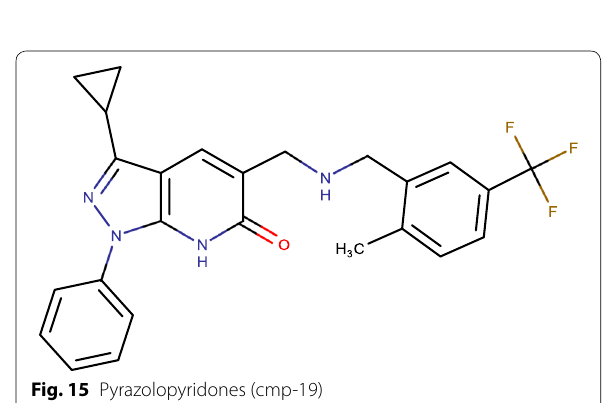
Fig. 15 Pyrazolopyridones